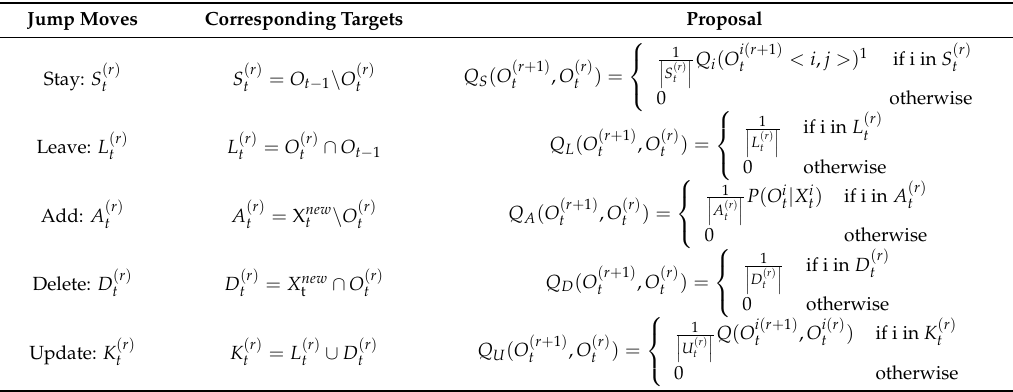
Table 1. The proposal of targets’ jump